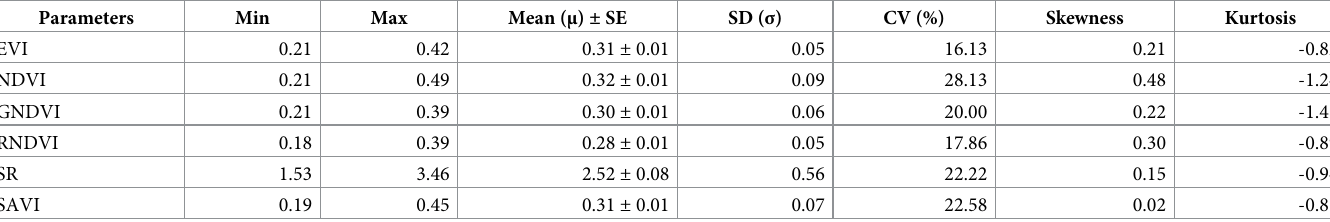
Table 2. Summary of descriptive statistics for spectral vegetation indices of maize in the Aba Gerima catchment. Parameters